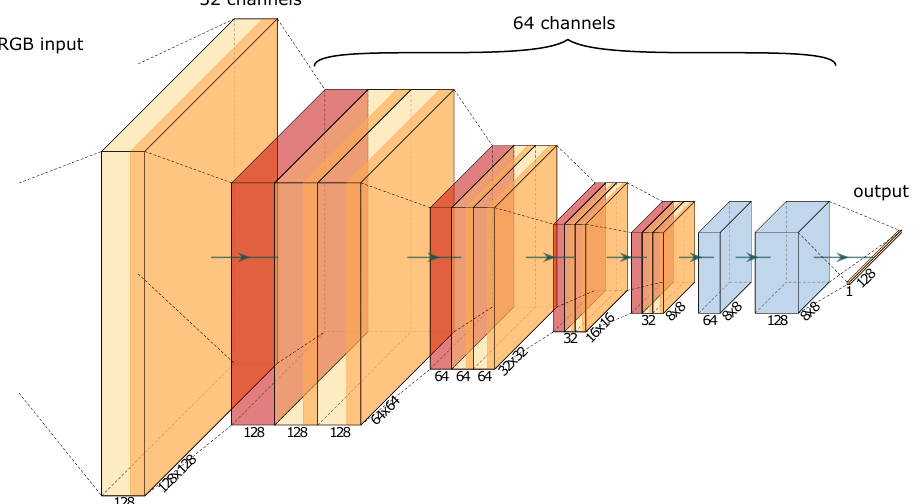
Figure 3. Illustration of the convolutional and average pool layers of the PhysNet architecture. The input is 128 stacked frames. Orange color denotes the convolutional, blue the deconvolutional (transposed convolutional) and red the average pool layers. At the bottom of each layer the time depth is shown and after the layer-blocks the spatial resolution. The output is the corresponding pulse